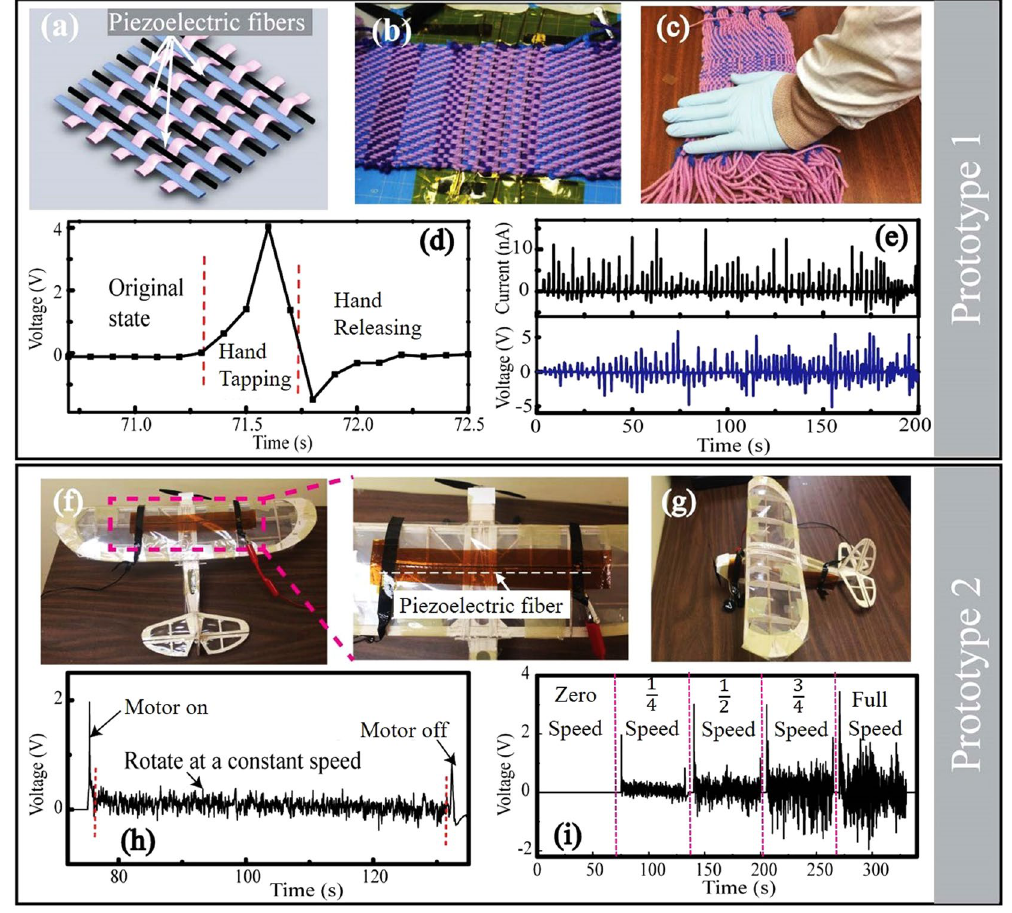
Figure 7. Potential applications of the piezoelectric fiber generators. ( a , b ) A cotton-based textile containing piezoelectric fibers woven using a Dobby loom. ( c ) Electrical properties of the piezoelectric textile actuated by the human hand tapping. ( d ) Open-circuit voltages of the piezoelectric textile in a hand tapping-releasing actions. ( e ) Open-circuit voltages and short-circuit currents generated by the piezoelectric textile during repeated hand tap-release motions. ( f , g ) Piezoelectric fibers implanted on the airplane wing ( f ) and the airplane body ( g ). ( h ) Open-circuit voltages generated by the piezoelectric fibers during rotation of the airplane propeller ( i ). ( h ) Open-circuit voltages generated by the vibrations induced by the airplane motor operation with the motor speeds set at zero, 1/4, 1/2, 3/4 of its maximum